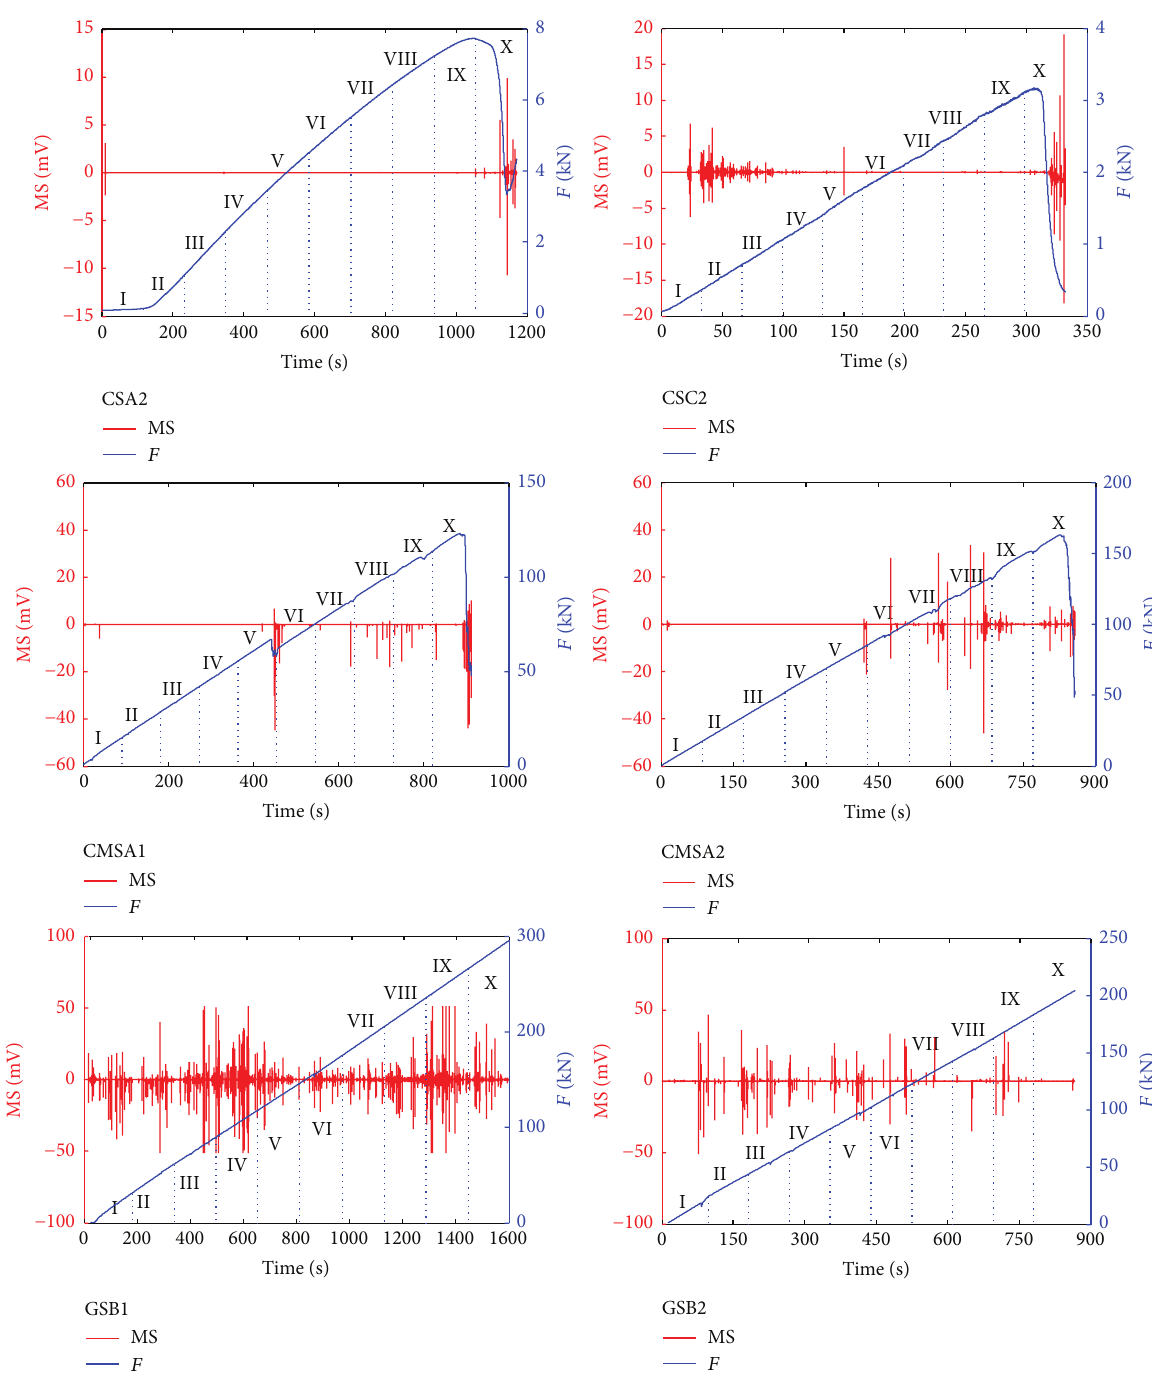
Figure 4: The MS events signal with increase of loading stress and